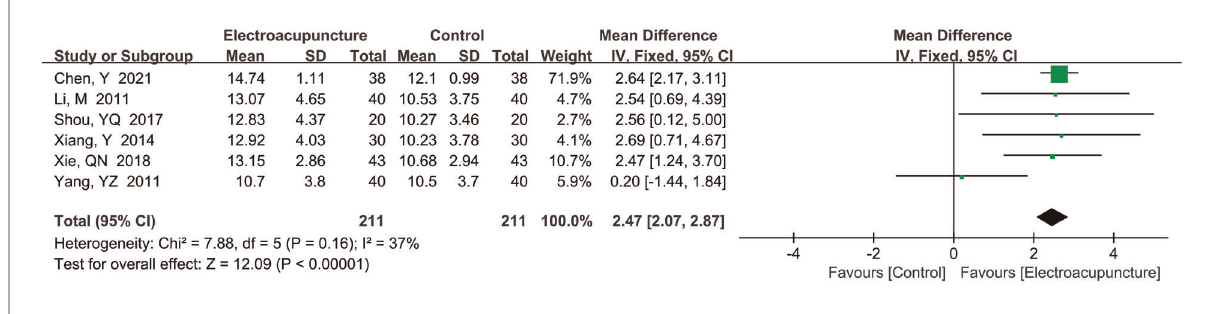
FIGURE 11 A forest plot showing the middle fi nger-carpal SNAP.